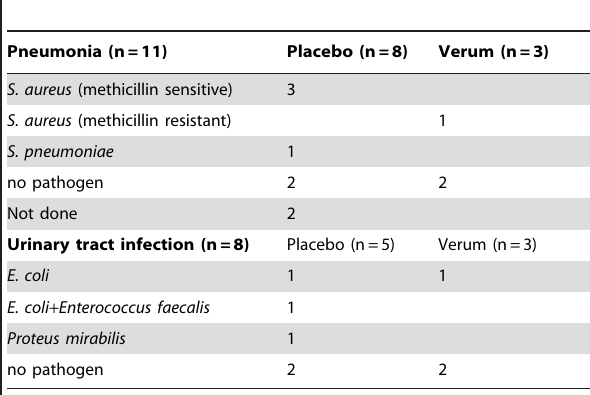
Table 3. Bacterial pathogens isolated from stroke patients specified for pneumonia and urinary tract infection